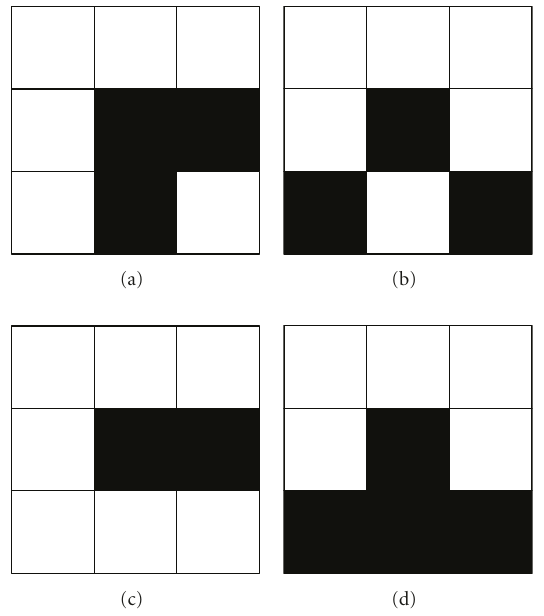
Figure 3: Basic singularity point structures. (a) and (b) the junction point structures. (c) and (d) the endpoint structures. Note that the center point is the target point